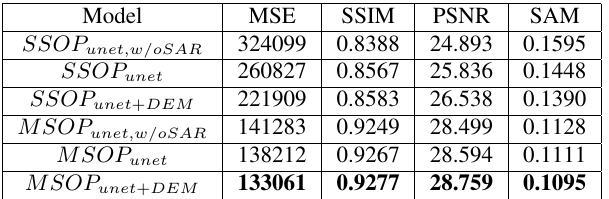
Table 8. Comparison between SSOP and MSOP networks, over the MSOP test dataset detailed in section